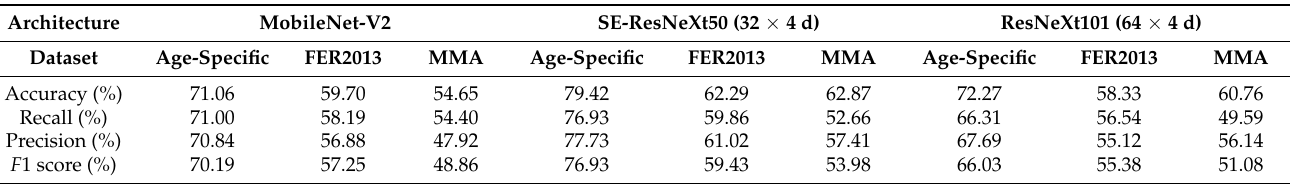
Table 6. Comparison of our dataset and the existing dataset of each architecture.